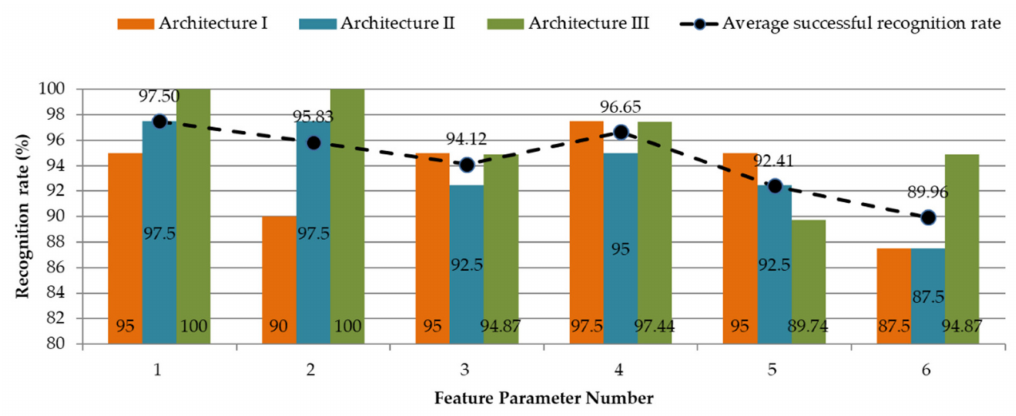
Figure 28. The successful recognition rate of each architecture (GIS-2).